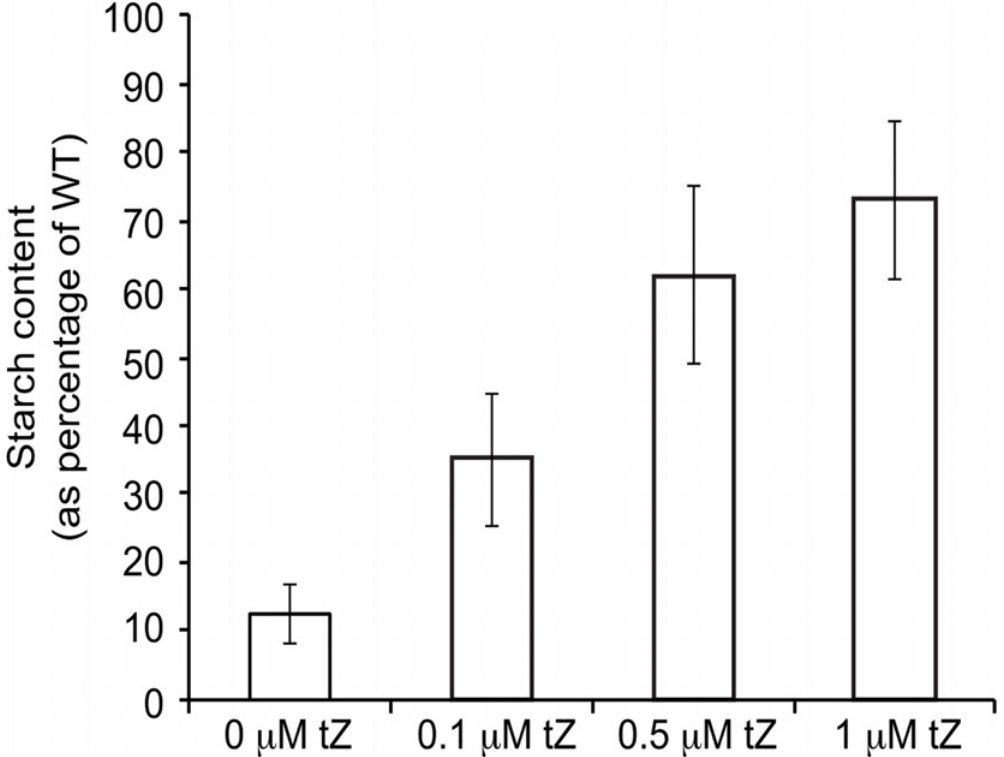
Fig 14. Starch content (as percentage of starch occurring in WT leaves) in leaves of pgi1 – 2 cultured in MS medium including the indicated concentrations of tZ. Values represent the mean ± SE of determinations on four independent